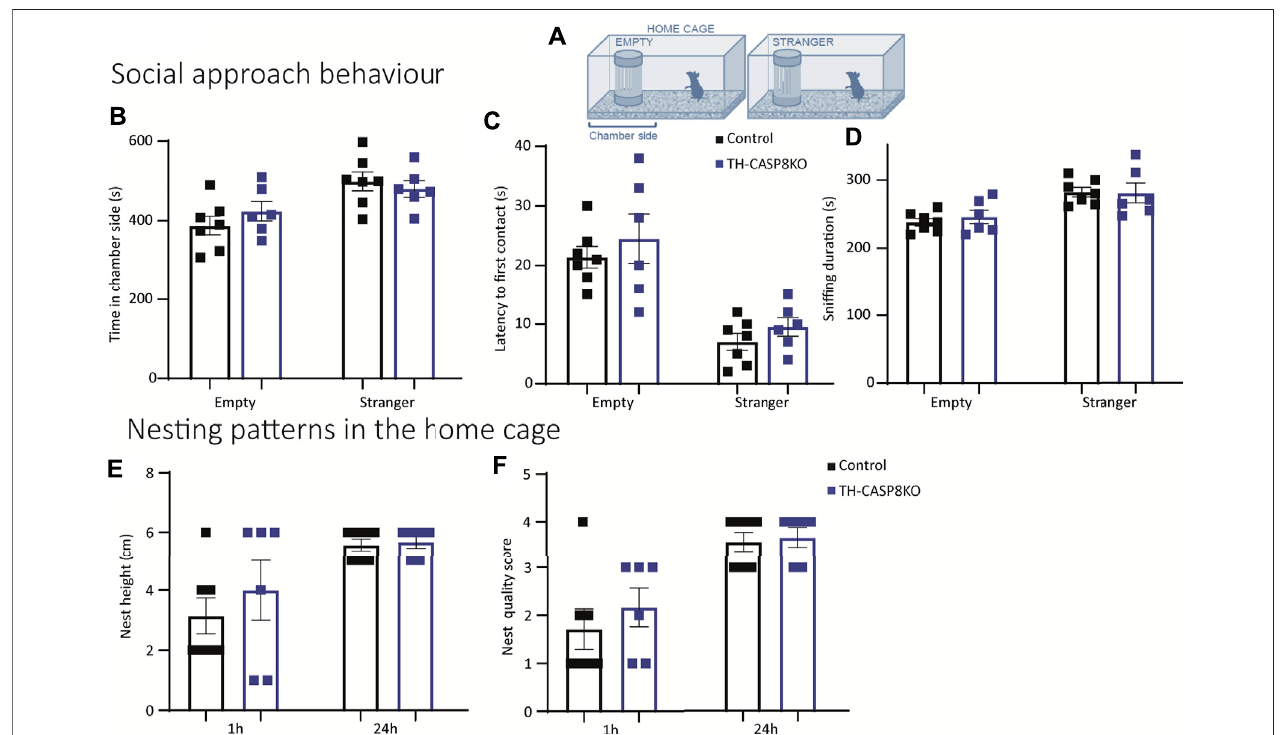
FIGURE 8 | Social interaction and nesting ability in TH-CASP8KO mice. (A) Diagram of a test box (home cage) containing a small compartment that is empty or occupiedbystrangermice(fromadifferentstrain). (B) TH-CASP8KOmicewithasimilartimeincloseproximitytotheobject(emptycompartment)orthestrangermouse (time in chamber side), and an equal time away from it than the control group. Similarly, no differences were found in the latency to fi rst contact (C) and in the duration of snif fi ng the object or the stranger mouse between the experimental groups (D) . The height (E) and quality score (F) of the nest was similar in TH-CASP8KO and control mice at 1 h and at 24 h. Data are expressed as mean ± SEM of n = 6 – 7 mice/group. The two-tailed unpaired t test was used.